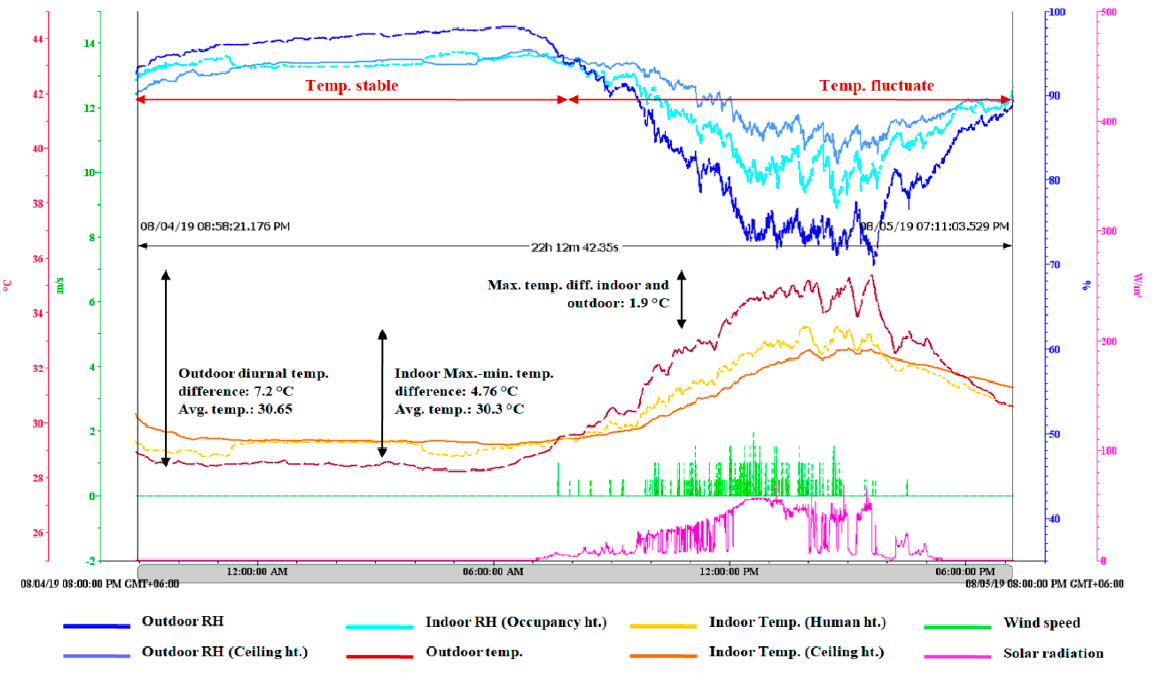
Figure 8. Indoor thermal performance of H-1 (Source: Field data from HOBO weather sta- tion).